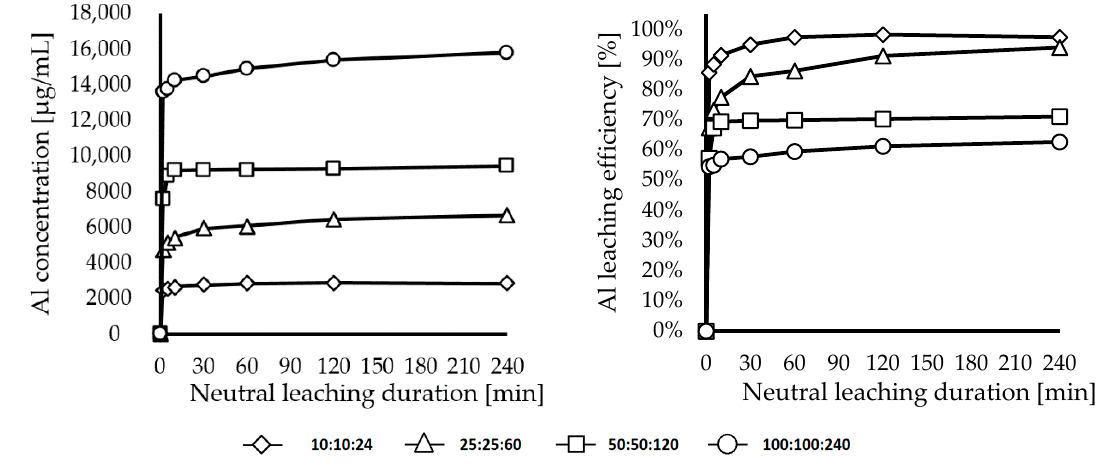
Figure 21. Lithium concentration and leaching efficiency.